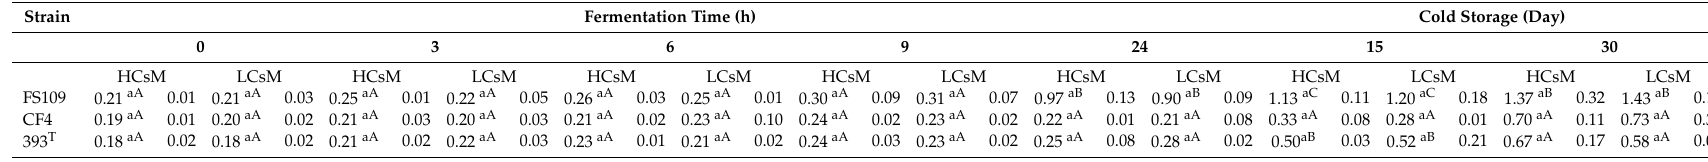
Table 4. Evolution of titratable acidity (% lactic acid) of HCsM and LCsM bulk milk fermented with L. paracasei strains during fermentation time and cold storage.